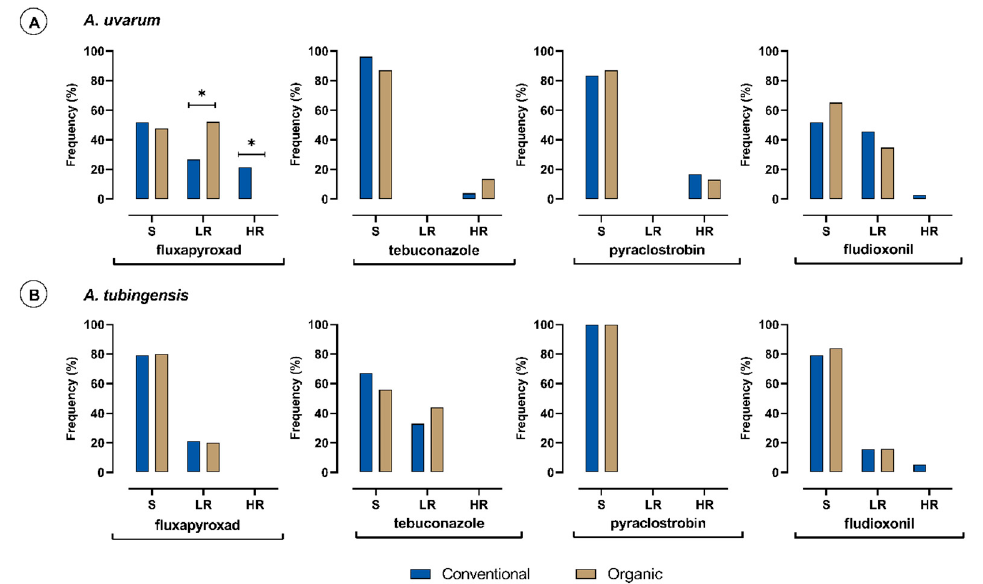
Figure 1. Frequency (%) of sensitive (S), lowly resistant (LR), and highly resistant (HR) isolates of Aspergillus uvarum ( A ) ( n = 102) and Aspergillus tubingensis ( B ) ( n = 151) populations obtained from conventional (blue columns) or organic (brown columns) vineyards to fluxapyroxad, tebuconazole, pyraclostrobin, and fludioxonil. Asterisk (*) indicates significant differences between the two farming systems according to a series of z -test analyses ( p = 0.05).